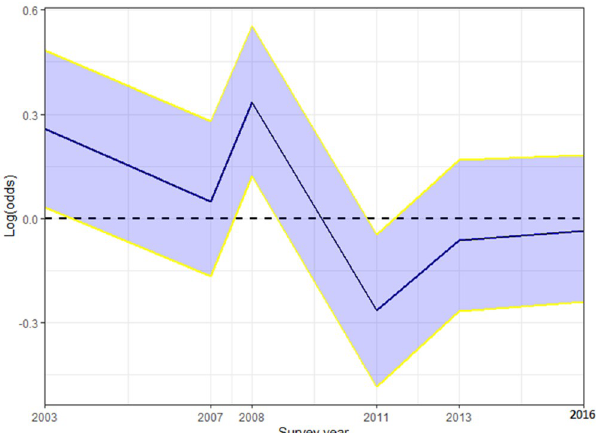
Fig 6. Temporal trends in FGM/C among 0-14-year old girls in Nigeria ( m 3 ) based on the pooled 2003 to 2016 dataset. The blue lines are the posterior means; the yellow lines are the 95% credible intervals of the posterior estimates; and the blue band is the width of the 95% credible